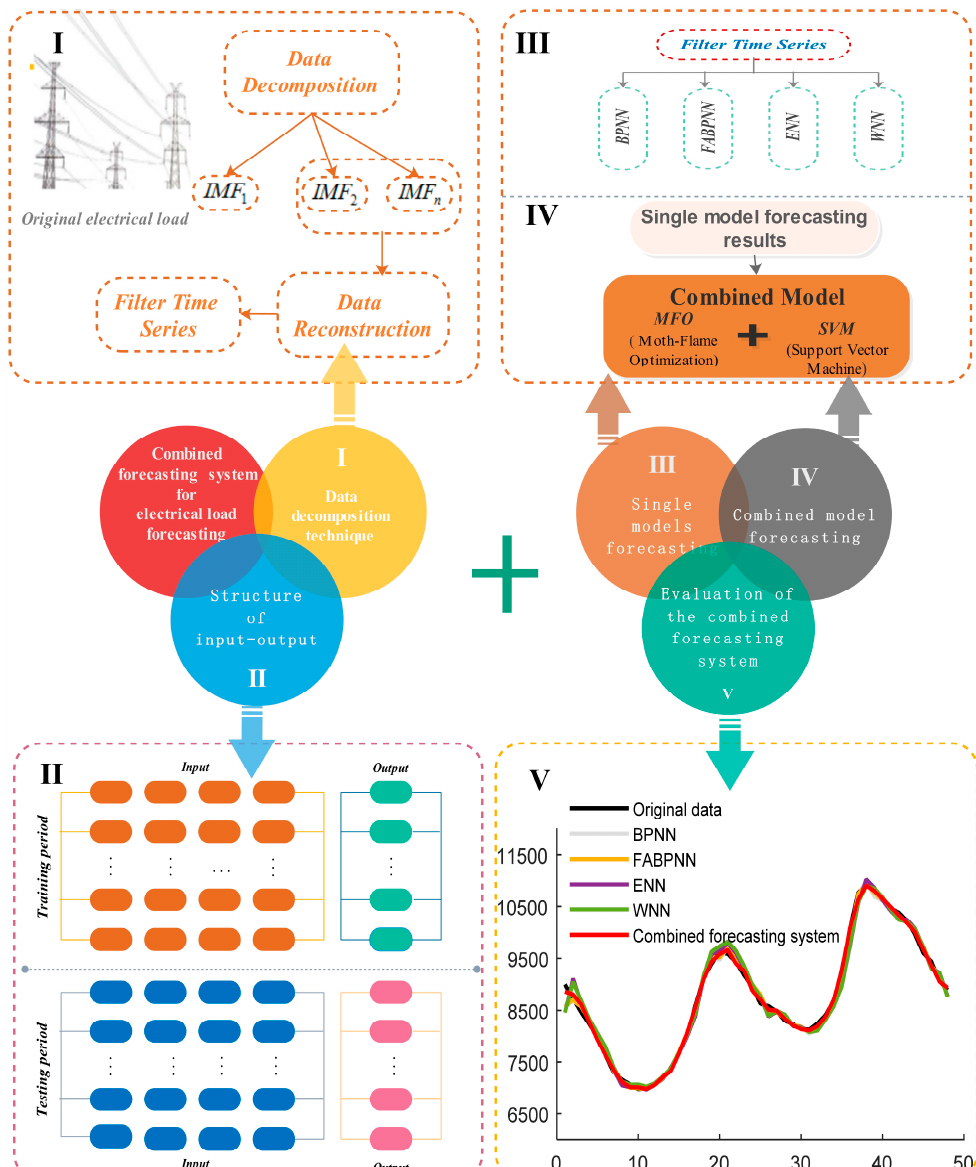
Figure 1. Flowchart of the proposed combined forecasting system.